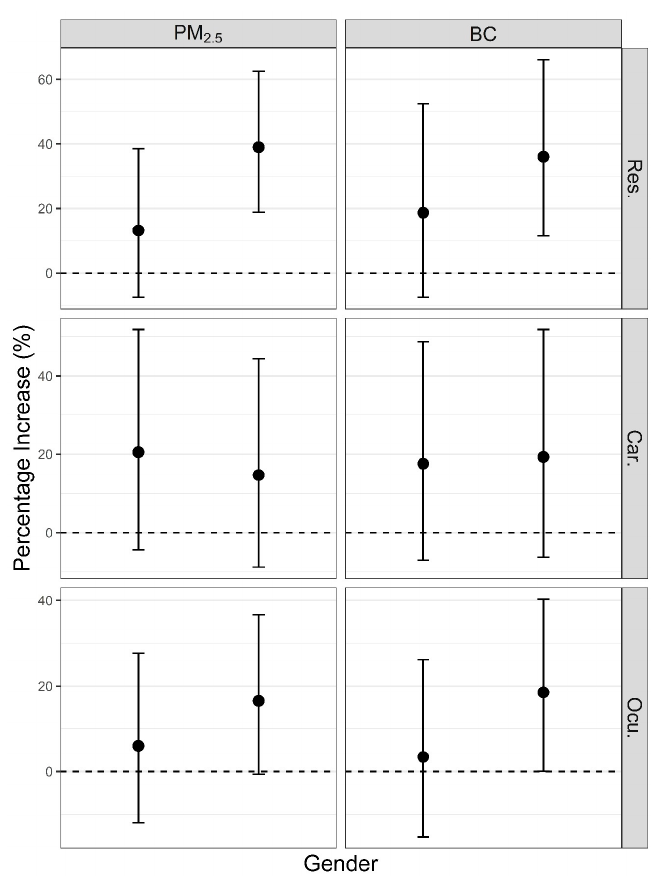
Figure 5. Estimated percentage increase in hospital ERVs (95% CI) for an IQR increase in PM 2.5 and BC in males and